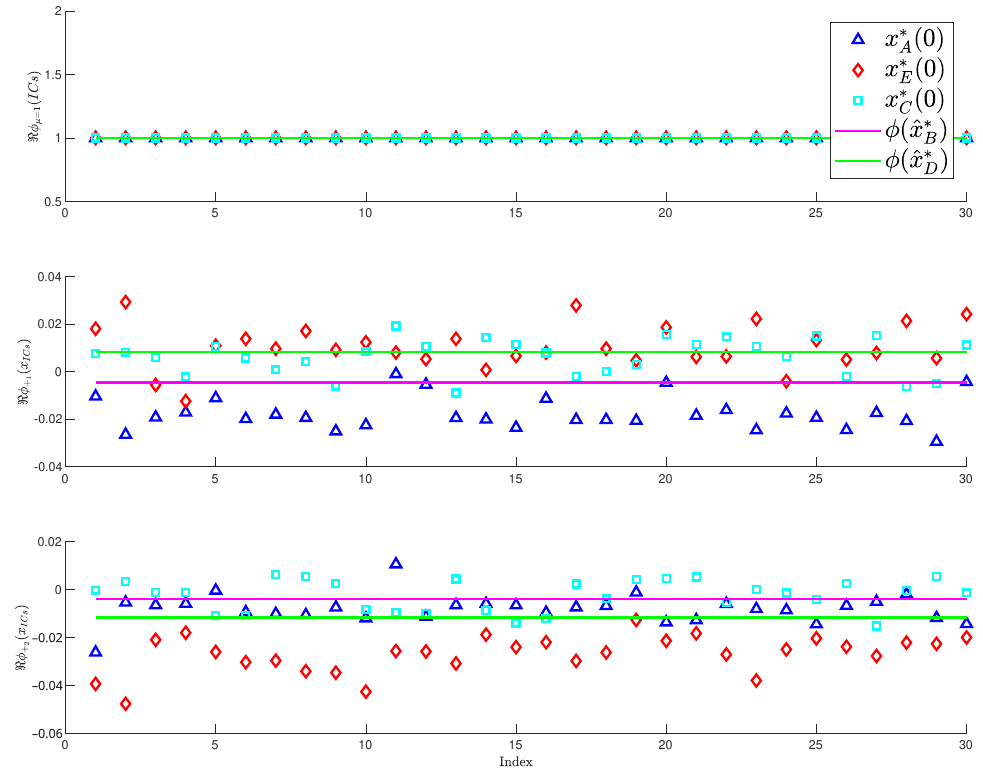
Figure 4. Eigenfunctions with unitary associated eigenvalue: ( top ) trivial; ( center ) µ > 1; ( bottom ) µ <